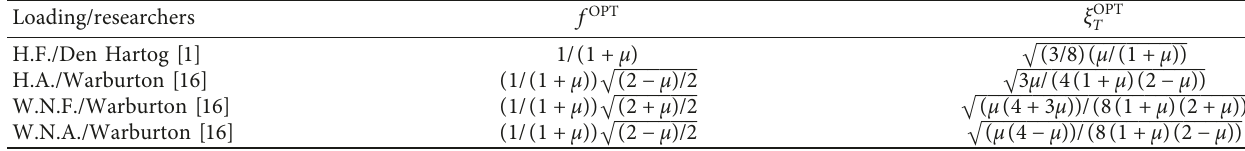
Table 1: Optimal TMD parameters for undamped primary structures.